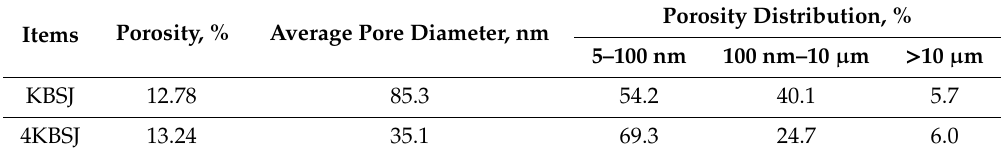
Table 3. Characteristic parameters and distribution of pore in mortar.